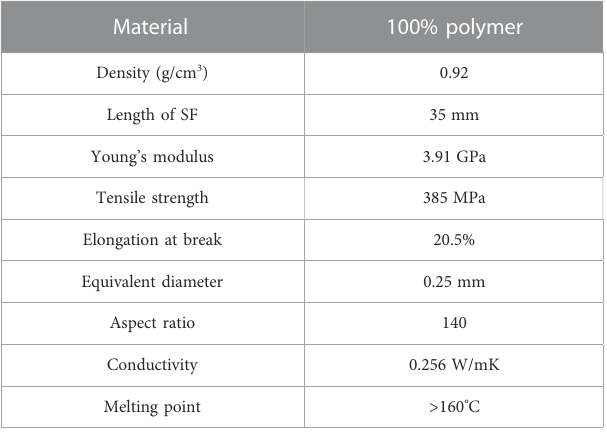
TABLE 1 Essential details and properties of synthetic twisted bundle macro- fi bers